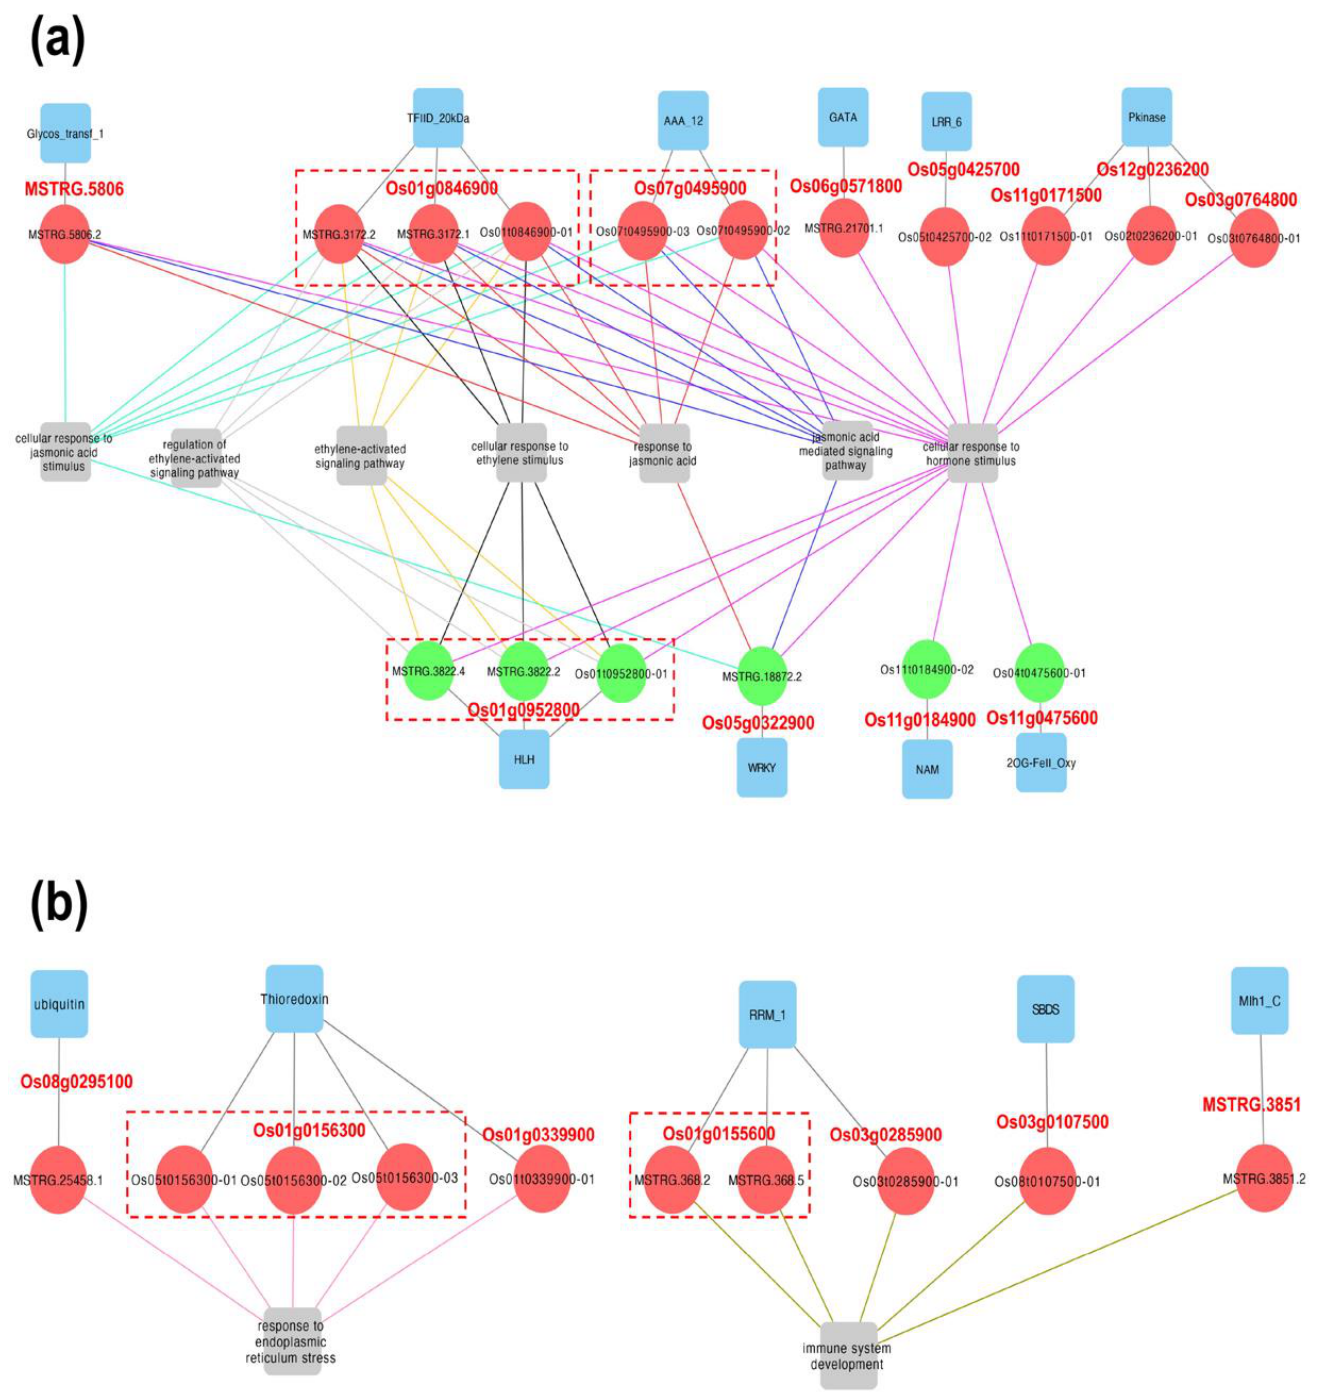
Figure 3. Defense-associated enriched Gene Ontology (GO) terms of #241-specific DASGs with adjusted p -value < 0.05 and GO level > 5 at ( a ) 24 hpi and ( b ) 48 hpi. Red dashed boxes marked alternative transcripts/isoforms produced by the same #241-specific DASGs, of which their accessions were listed. Circles with a red color mean up-regulated transcripts/isoforms; circles with a green color mean down-regulated transcripts/isoforms.